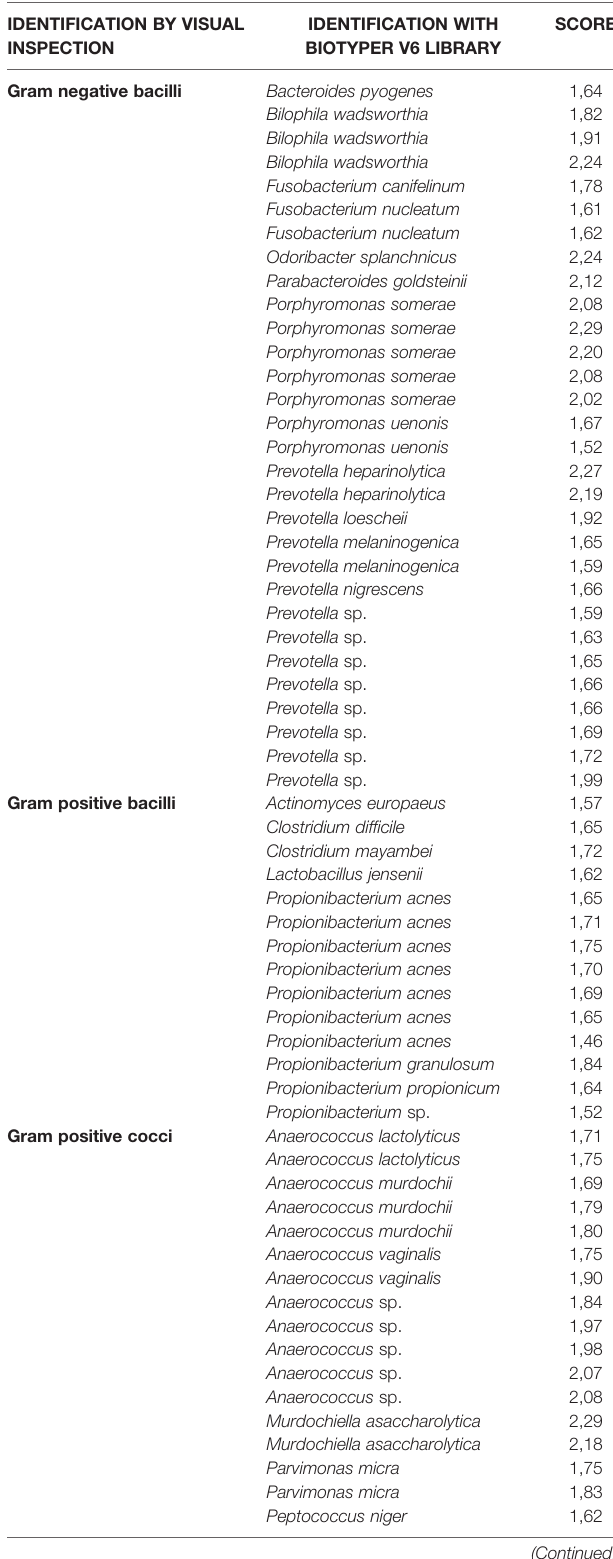
TABLE 2 | Isolates identi fi ed by MALDI-TOF MS only when the Biotyper V6 database – or a more upgraded library- was